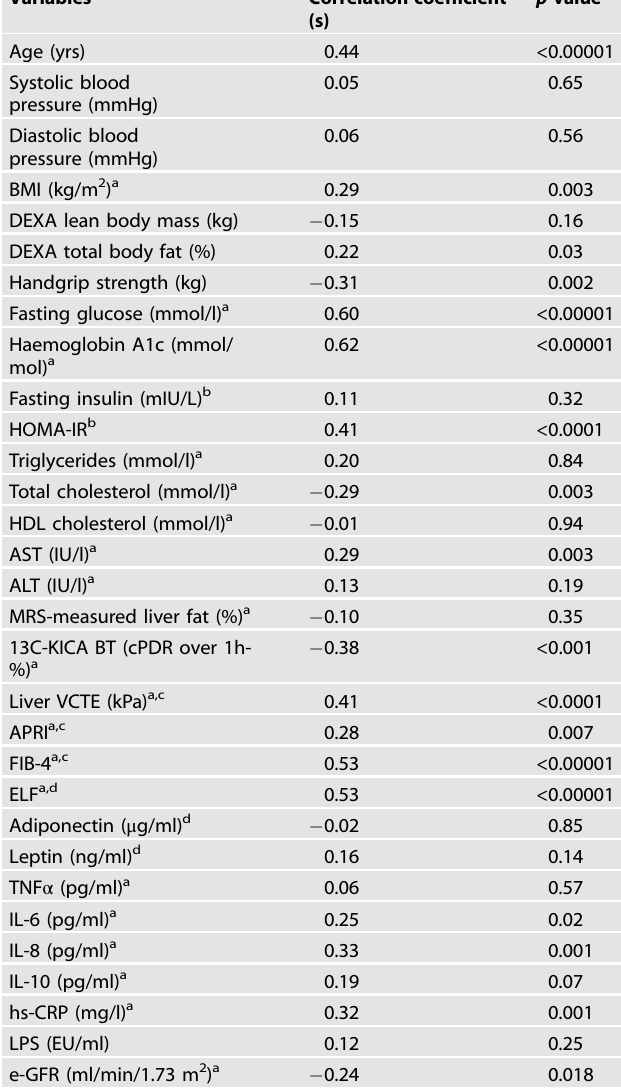
Table 3. Binary logistic regression analysis showing that only serum GDF-15 concentrations and T2DM status were signi fi cant independent